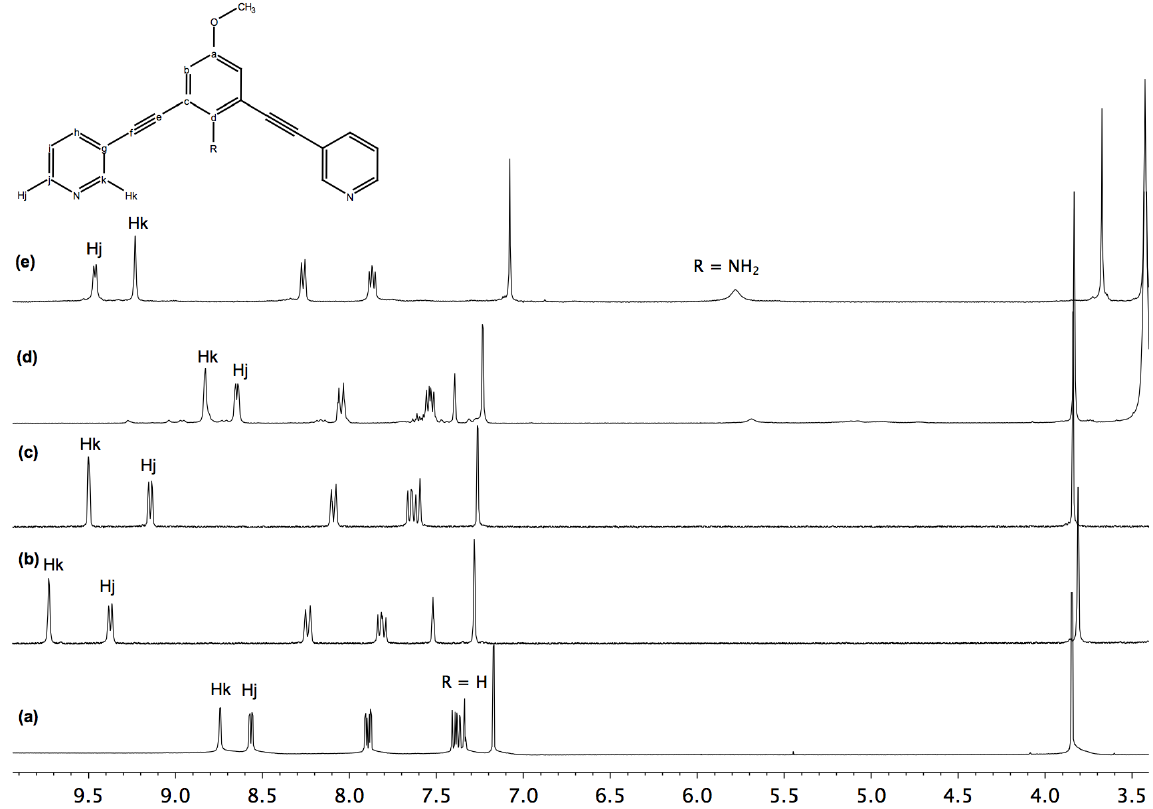
CN; ( b ) metallocage [Pd 3 ( L 1 ) ][OTf] ( 1b ) in CD 2 4 4